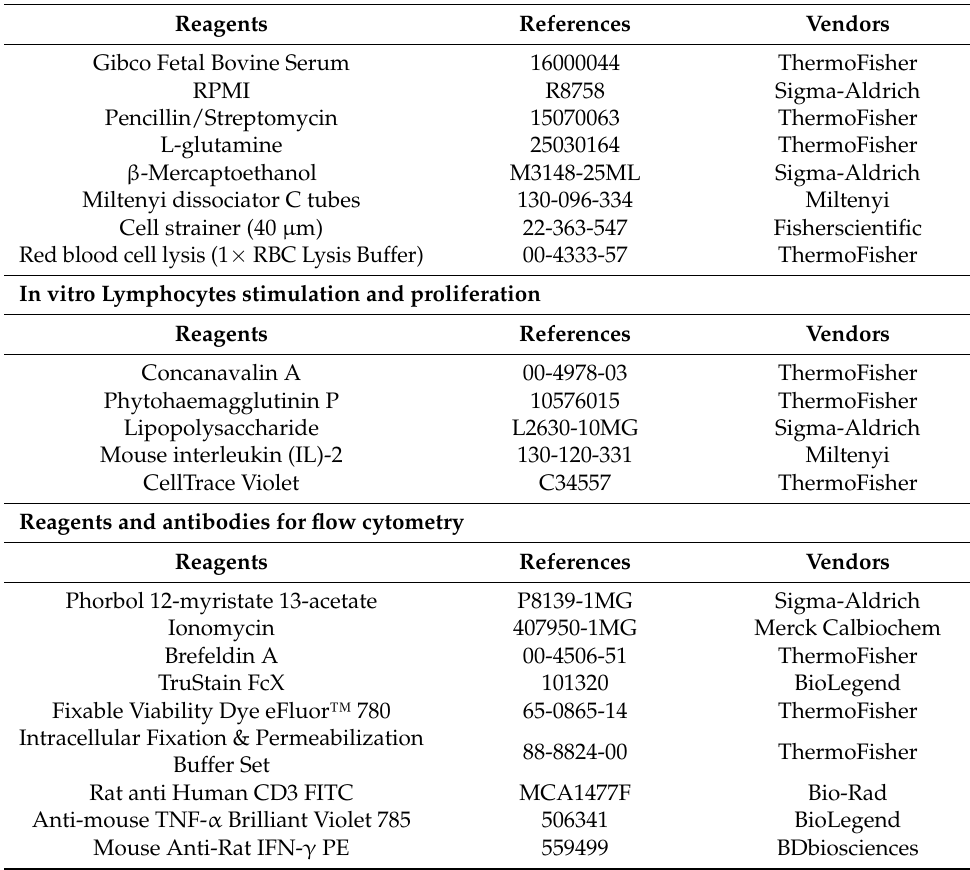
Table 1. List of reagents and antibodies used in this study. Mechanical and Tissue